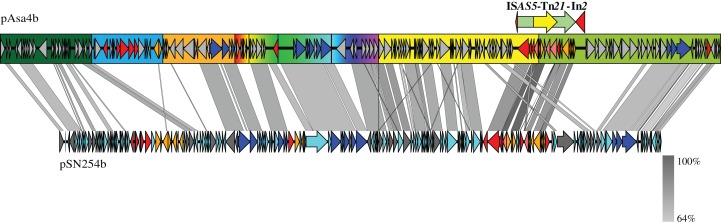
Nucleotide alignment between pAsa4b and pSN254b.Plasmid alignments and ORF representations were done with EasyFig (Sullivan, Petty & Beatson, 2011). The color codes and segments are the same as in Fig. 1.